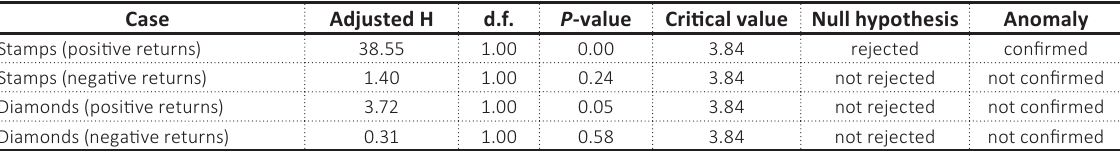
Table A4. Mann–Whitney U test